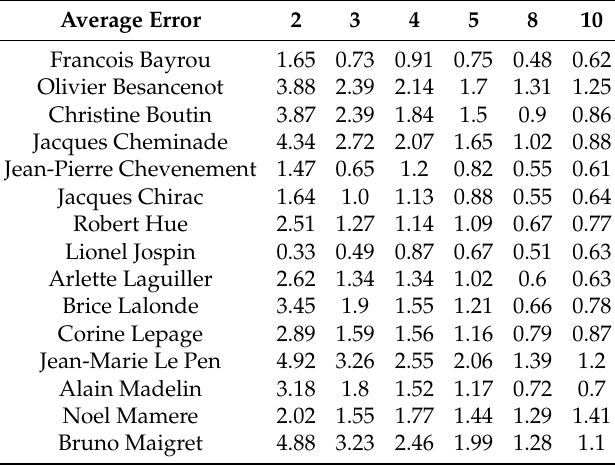
Table 19. Average rounding error for French